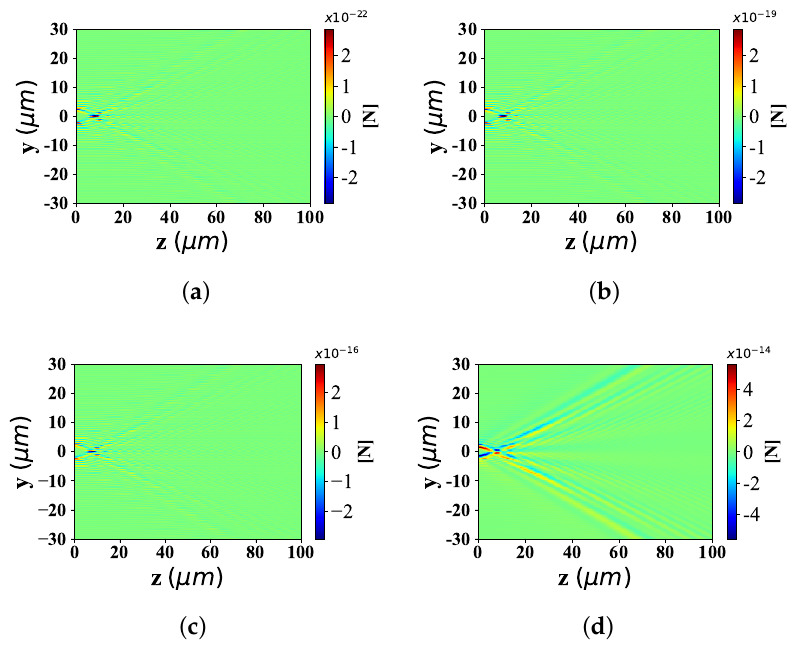
Figure 4. Distribution of F y under different spherical radius (radius is equal to 0.001 λ , 0.01 λ , 0.1 λ and λ , respectively) acting on Bessel pincer light-sheets beam ( λ = 0.532 µ m, α 0 = 0.5, and l = 10). ( a ) radius = 0.001 λ ; ( b ) radius = 0.01 λ ; ( c ) radius = 0.1 λ ; ( d ) radius = 1 λ .